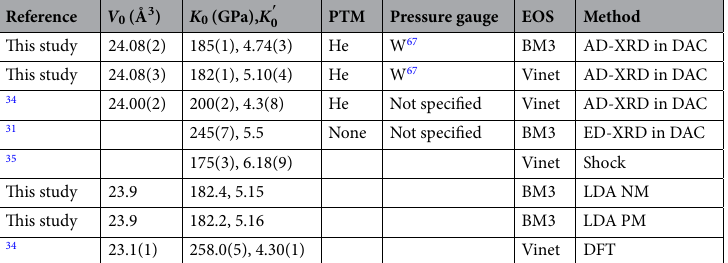
Table 3. EOS parameters of Cr measured and calculated in different experiments. The volume V 0 , the bulk modulus K 0 and its pressure derivative K ′ 0 are listed. Experimental methods and EOS formulation are